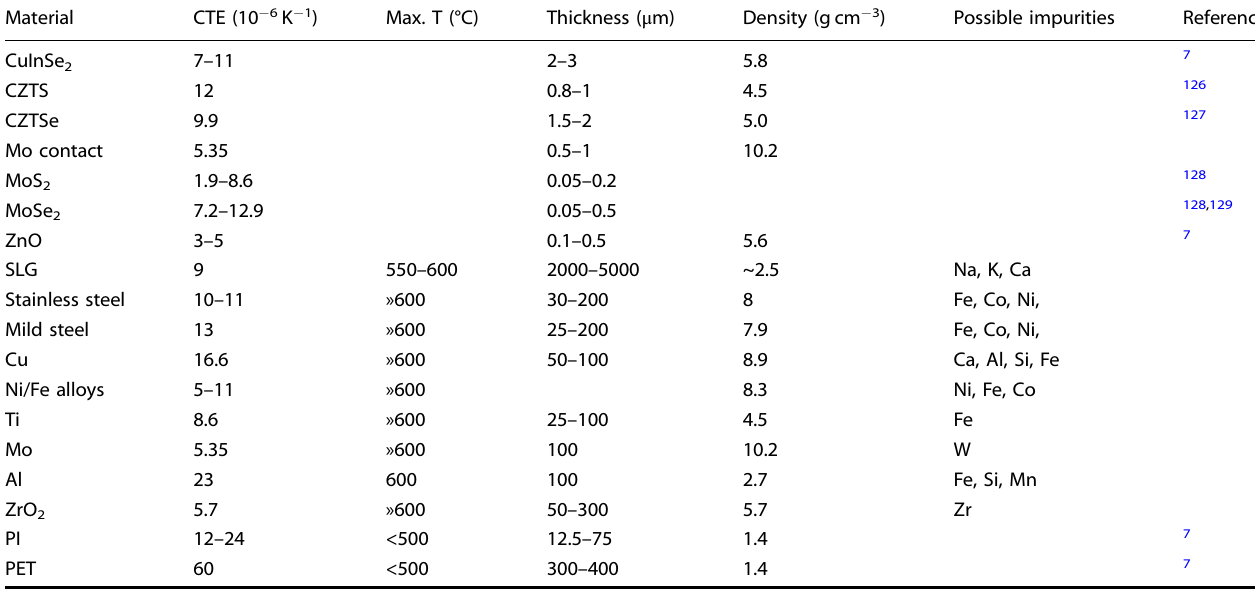
Table 3. Typical properties of materials and substrates used for fl exible CZTSSe thin- fi lm solar cells.